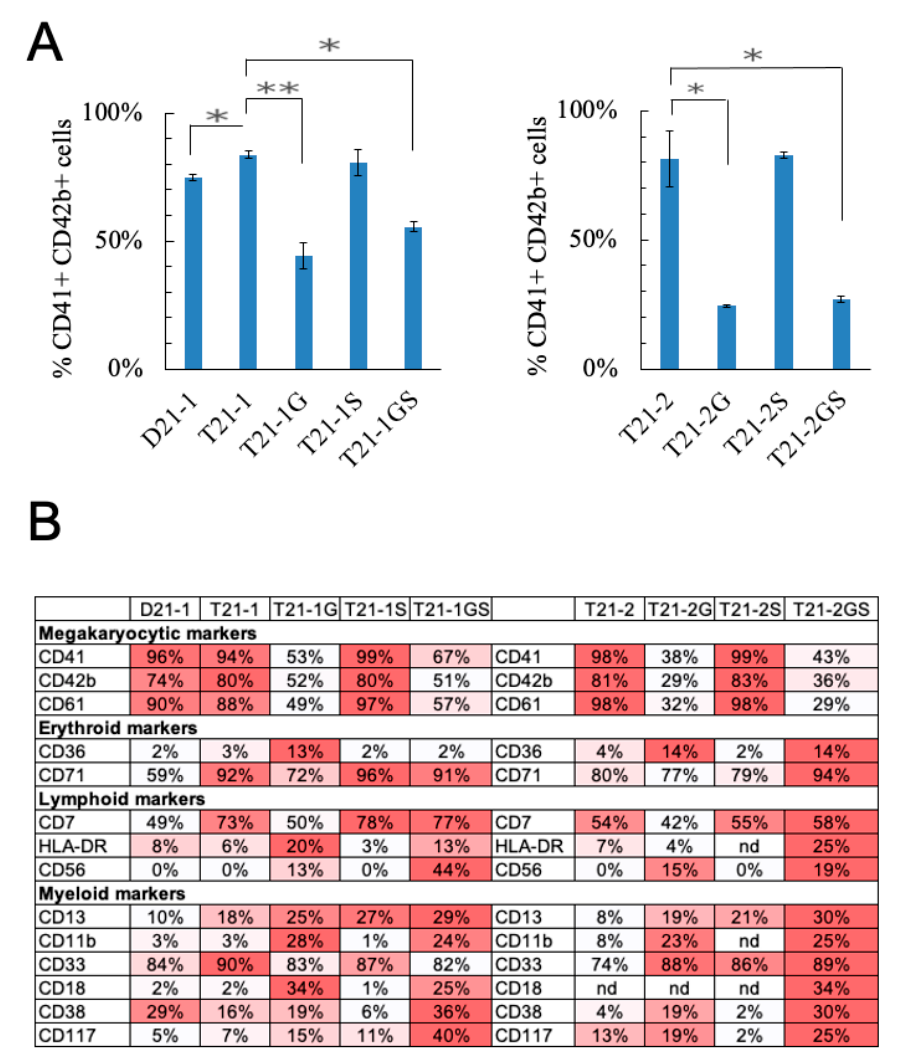
Figure 3. ( A ) Megakaryoblast population (CD41+CD42b+) in HSPCs cultured in media that promotes megakaryocytic lineage expansion is plotted. Error bars denote SE of the mean. Asterisk indicates statistical significance in indicated pair of iPSC lines, * p < 0.05, ** p < 0.01. ( B ) Immunophenotyping analysis of day 5 megakaryocytes. nd = not determined. The percentages of marker positive population are indicated. The darker color represents higher percentage.